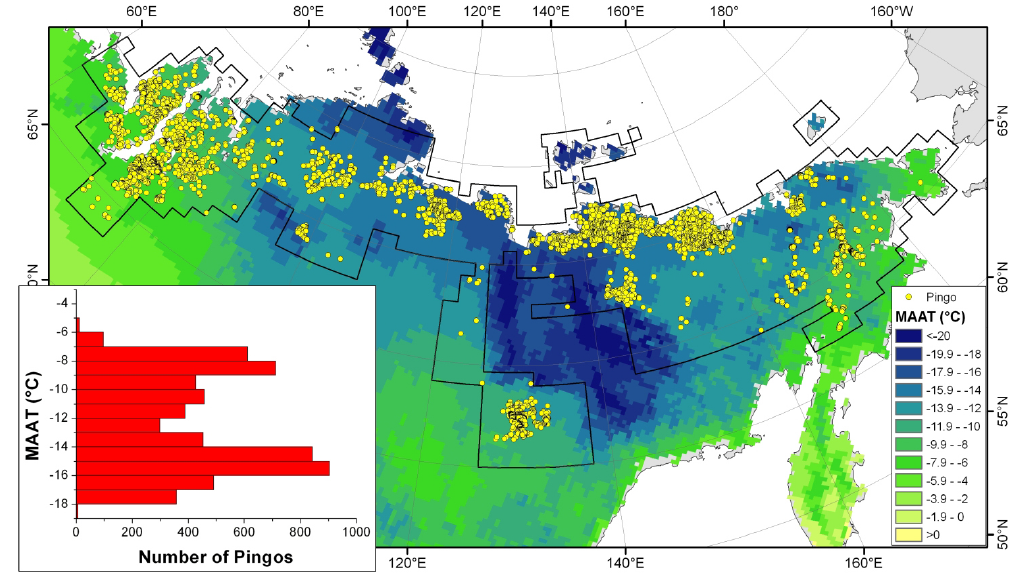
Fig. 11. Distribution of pingos by mean annual air temperature (MAAT) (based on Stolbovoy and McCallum,